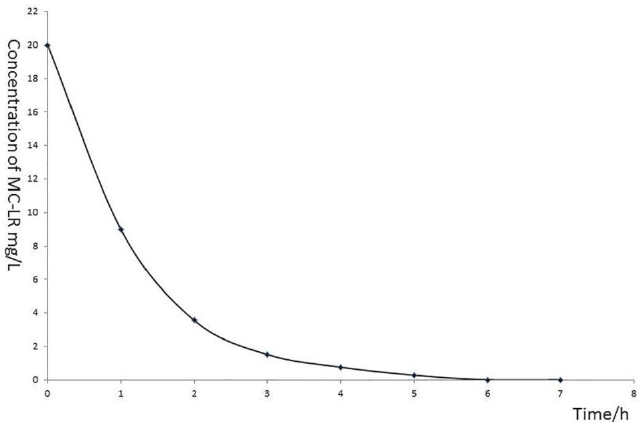
Figure 5. Degradation curve of standard MC-LR using strain a7.